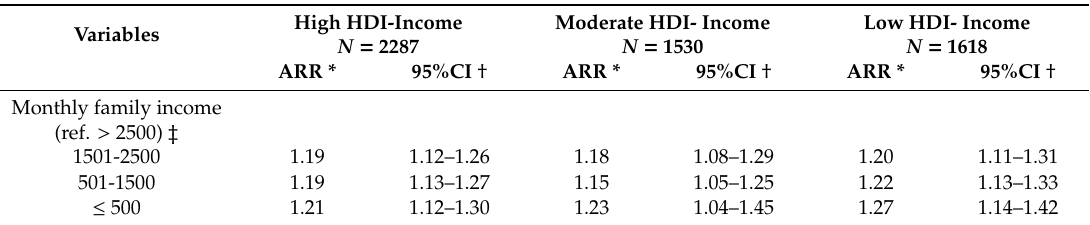
Table 5. Association between monthly family income and tooth loss among elderly people according to Human of Development Index income determined by multilevel negative binomial